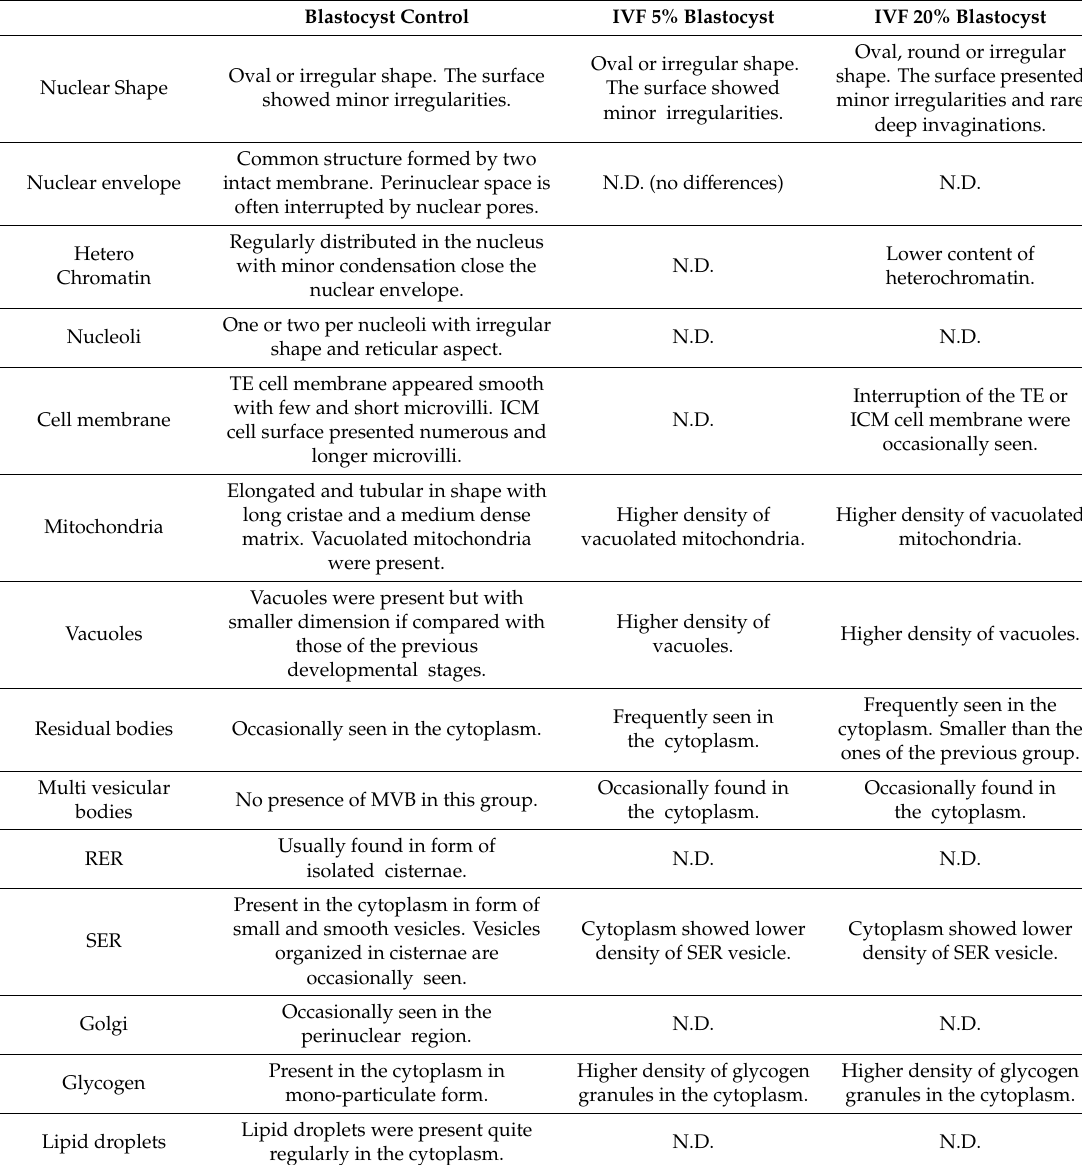
Table 2. Comparison of the main ultrastructural marker of quality among blastocyst groups (control vs IVF 5% and 20%). Legends: N.D.: no di ff